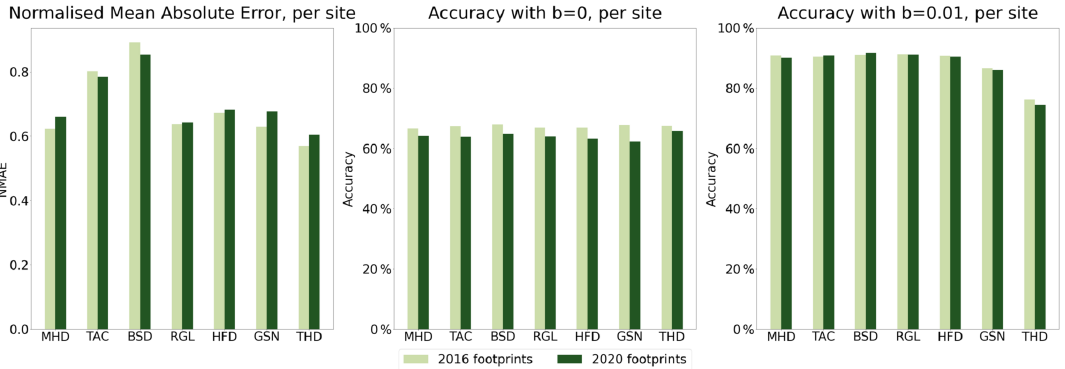
Figure 3. Evaluation of emulators with footprint-to-footprint comparison, using metrics NMAE and accuracy with b = 0 (all footprint values) and b = 0 . 01 (high values), shown per site and